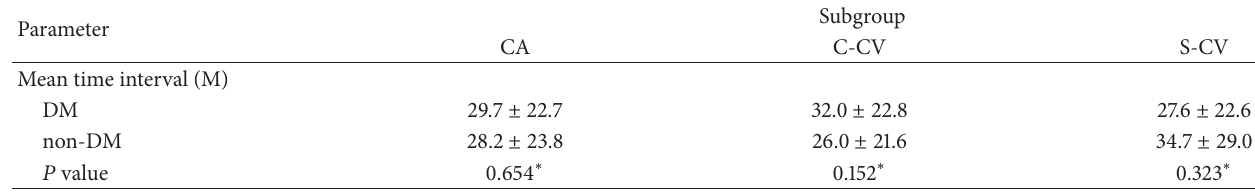
Table 5: Comparisons of the mean time interval from cataract surgery to Nd:YAG capsulotomy within the PPV subgroup.